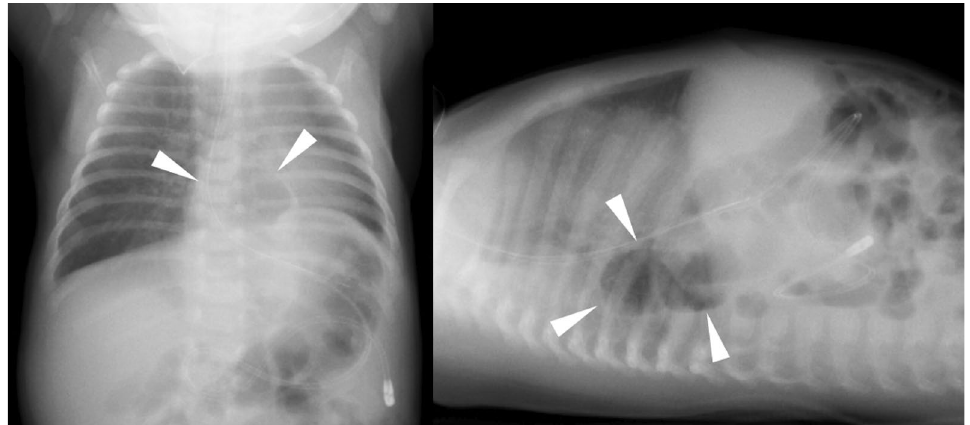
Fig. 2 Chest radiograph of a suspected recurrent left diaphragmatic hernia. Chest radiograph on postoperative day 35 shows bowel gas is present in the thoracic cavity (arrowhead)